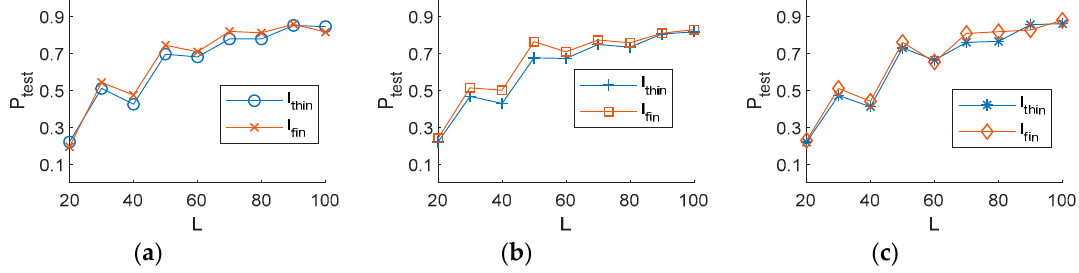
Figure 13. The comparison of the test accuracy of the original image and the contour thinning image changing with the image size. The horizontal axis in the figure represents the image size. The unit of the abscissa is pixel. The vertical axis represents the recognition accuracy: ( a ) The training images ratio β is 0.5; ( b ) The training images ratio β is 0.6; ( c ) The training images ratio β is 0.7.